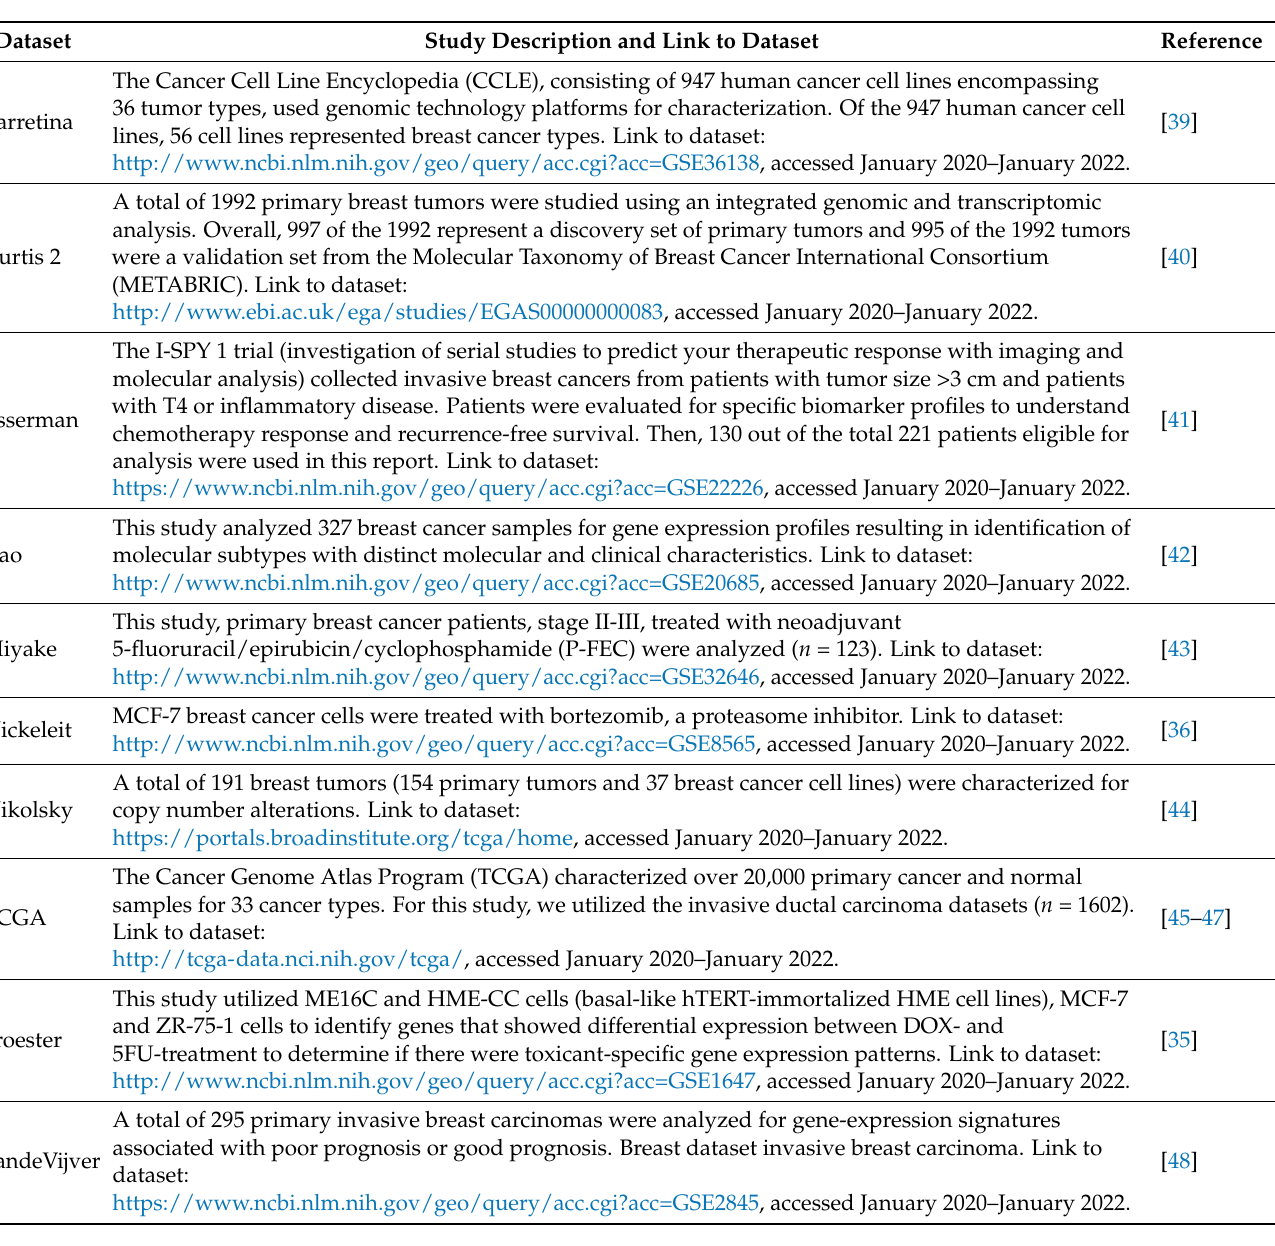
Table 1. Datasets used in study. Hyperlinks to datasets are